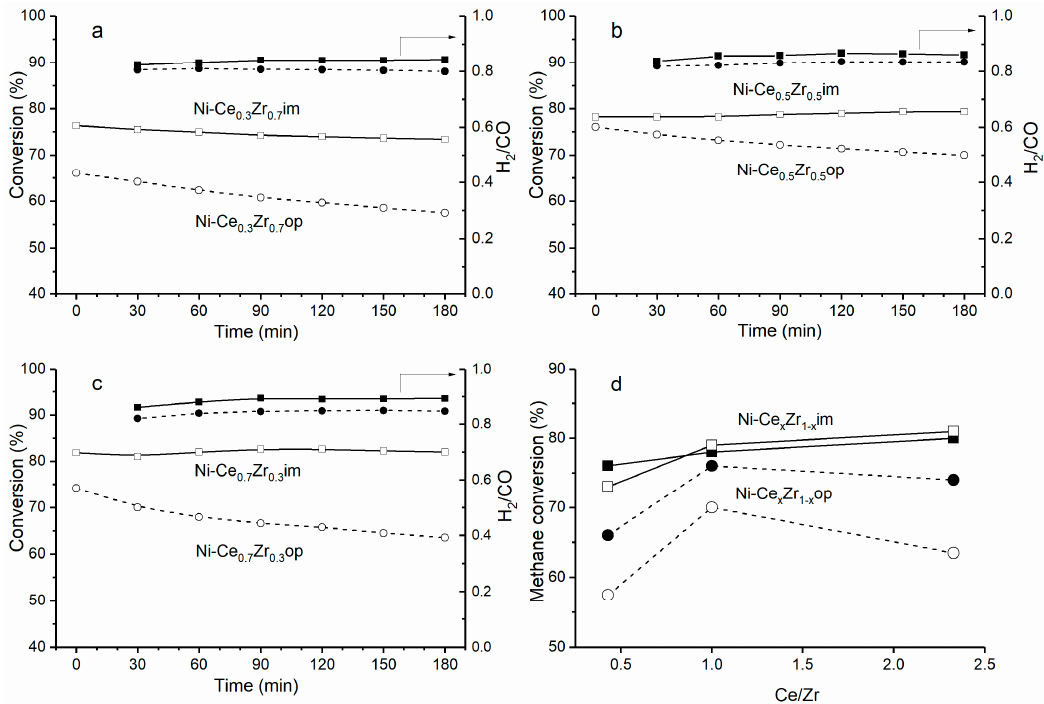
Figure 13. Conversion of methane and H 2 / CO during methane dry reforming (MDR) over Ni-Ce x Zr 1 − x catalysts: ( a ) Ni-Ce 0.3 Zr 0.7 ; ( b ) Ni-Ce 0.5 Zr 0.5 ; ( c ) Ni-Ce 0.7 Zr 0.3 ; ( d ) dependence of initial (filled symbols) and final (empty symbols) CH 4 conversion on Ce / Zr ratio.